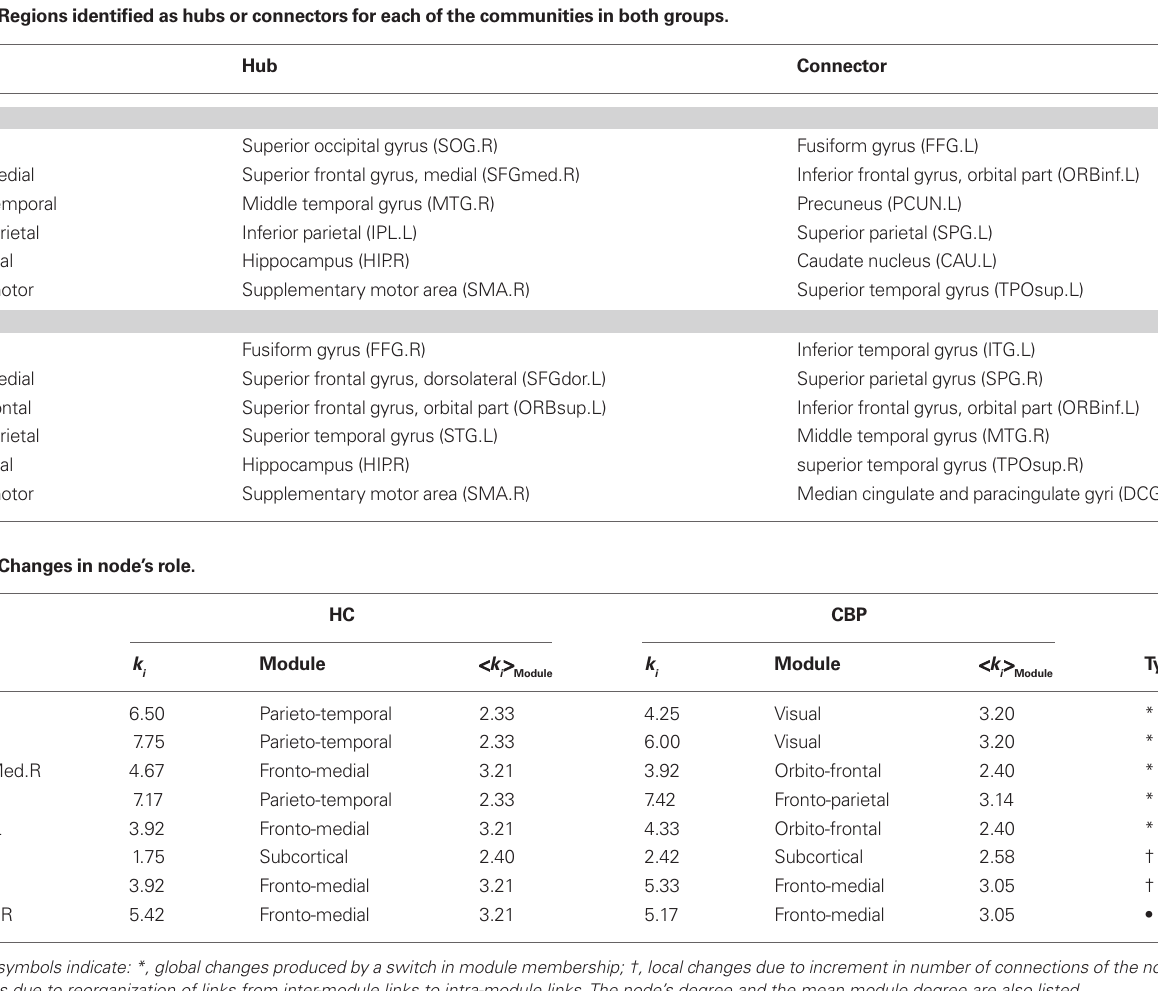
Table 1 | regions identified as hubs or connectors for each of the communities in both groups. Module